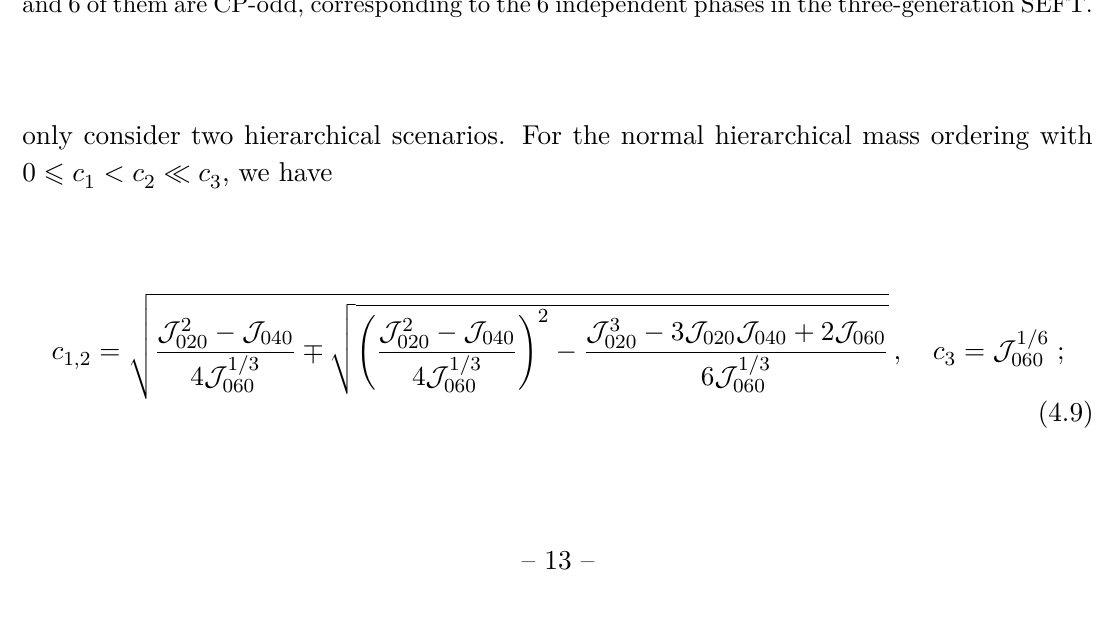
, G and ≡ C C † ≡ C X ∗ C † 5 5 5 5 5 l 5 l